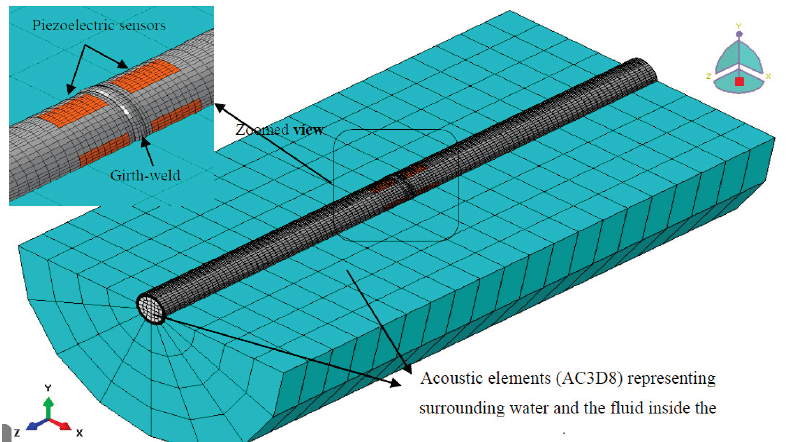
Figure 1. Finite element model of the submerged pipe incorporating piezoelectric